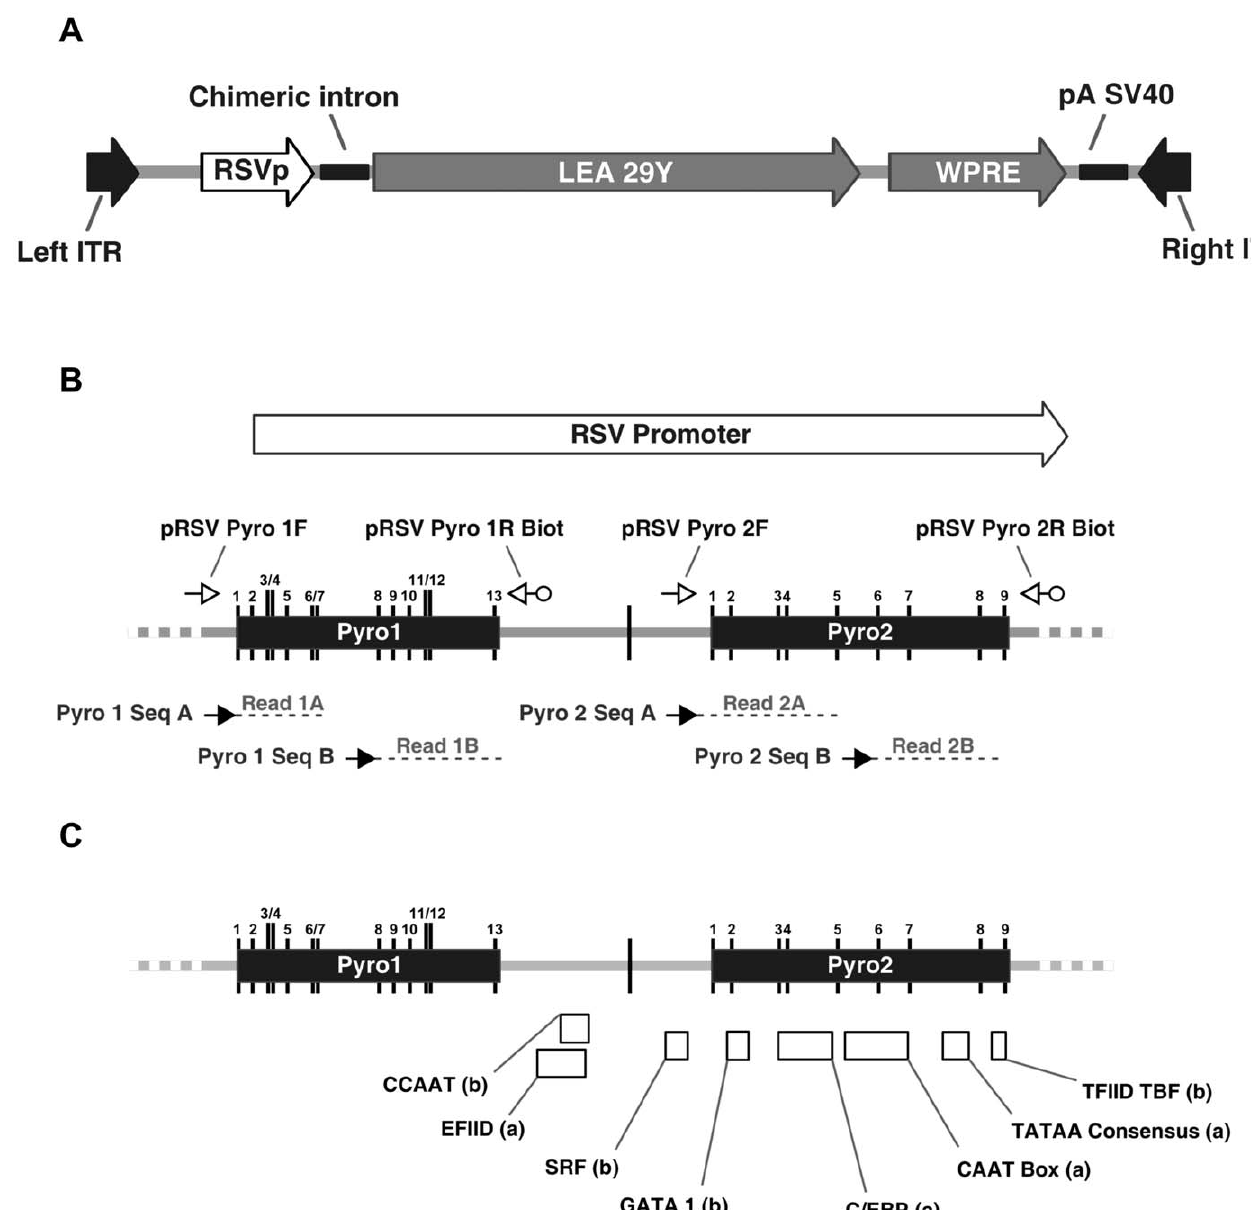
Figure 1. Pyrosequencing assay for the Rous Sarcoma Virus promoter (RSVp) and transcription factor binding sites. (A) Schematic representation of the rAAV-RSV-LEA29Y-WPRE-pA genome. The LEA29Y reporter gene sequence was cloned upstream of the Rous sarcoma virus (RSV) promoter and downstream of the Woodchuck hepatitis virus posttranscriptional regulatory element (WPRE). (B) Two high-density CpGs plots were identified in the RSVp, named Pyro1 and Pyro2 (black boxes). CpG positions are marked by black vertical lines and numbered from 1 to 13 for the 1 st CpG-rich region, Pyro1, and from 1 to 9 to the 2 nd region, Pyro2. PCR primers used to specifically amplify bisulfite-converted rAAV vector DNA are represented as small open arrows. Reverse primers are 5 9 -biotinylated allowing specific capture and subsequent purification of the PCR product. Pyrosequencing allowed examination of 22 of 23 CpGs from the RSVp using the 4 sequencing primers represented as small black arrows. (C) Transcription factor binding sites positions along the RSVp. (a) TF binding sites described by Mobley et al. [53]. (b) TF binding sites predicted by in silico analysis using EMBOSS TFscan (http://mobyle.pasteur.fr).